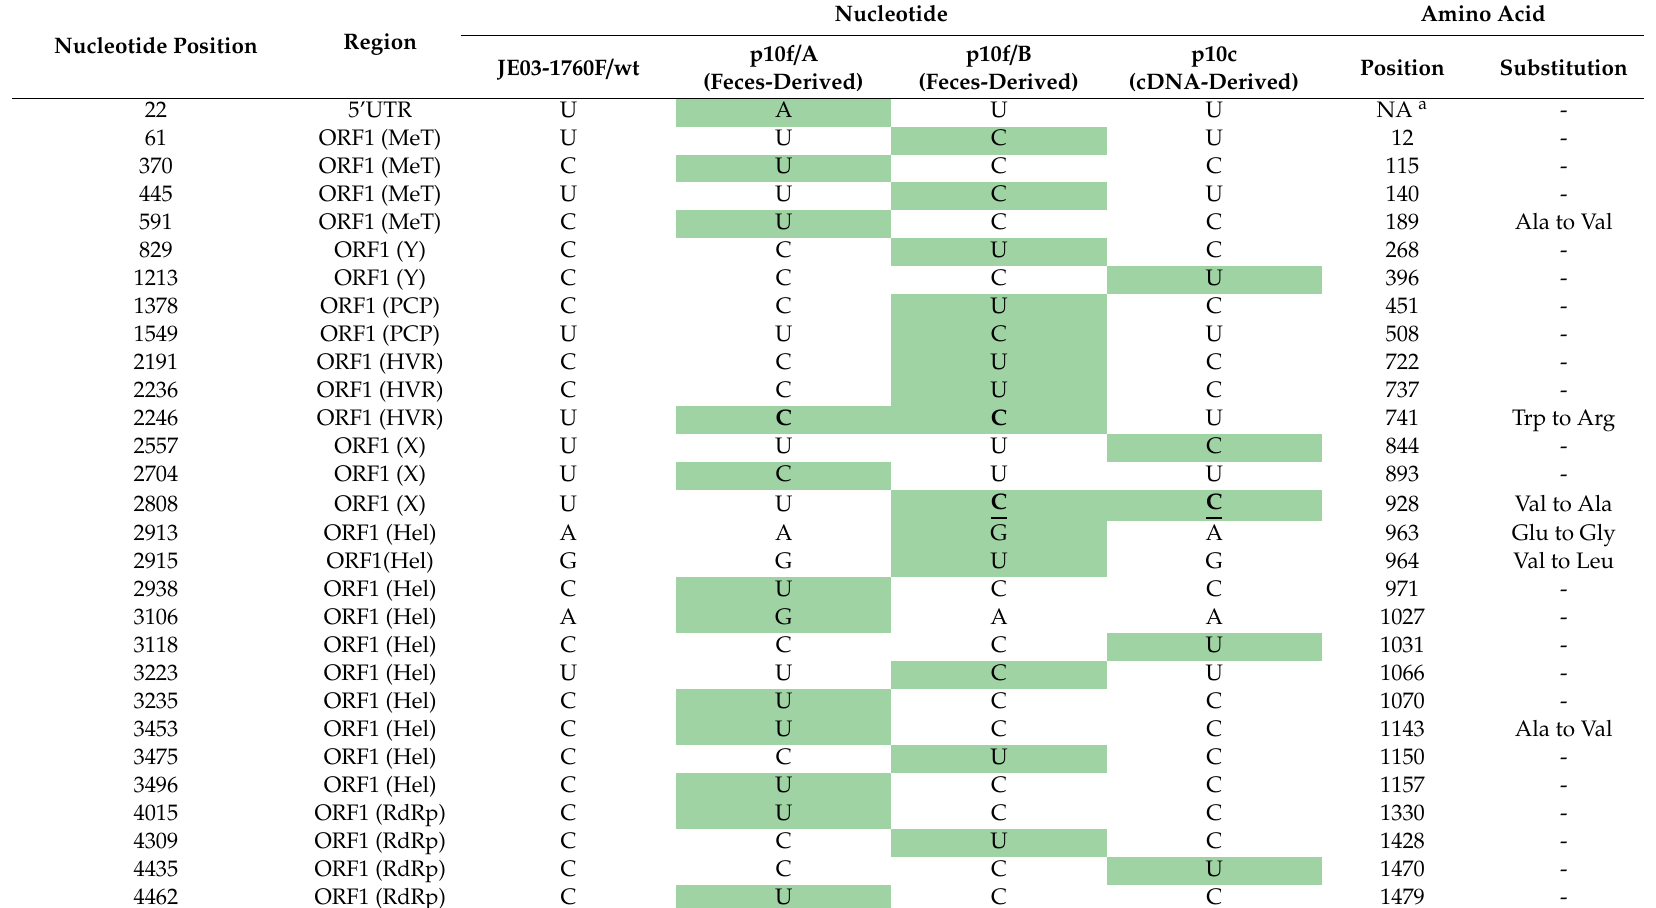
Table 2. A comparison of sequences of the wild-type (wt) JE03-1760F, its cell culture-produced variants (feces-derived) and the cell culture-produced variant of pJE03-1760F / wt (cDNA-derived) over the entire